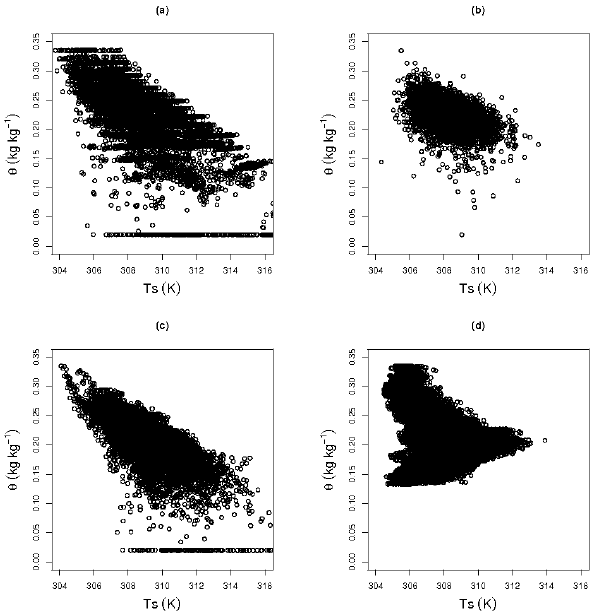
Fig. 5. Scatterplots of soil moisture ( θ , [kg kg − 1 ]) and surface tem- perature ( T s , [K]) for low wind speed scenario at the final time step for different levels of decomposition (a) 100m (b) 200m (c) 1600m and (d) 12800m.